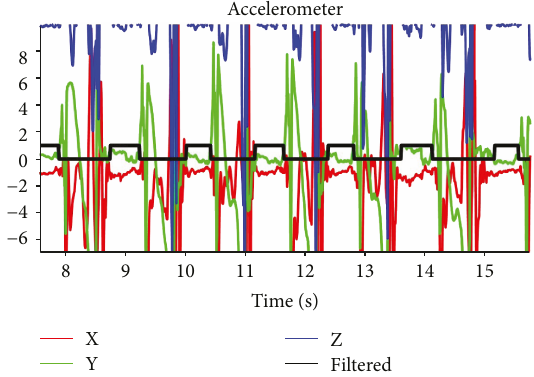
Figure 6: Gait recognition results based on improved zero-velocity update